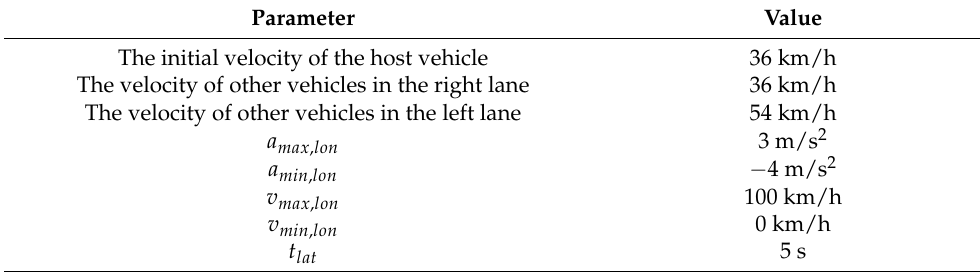
Figure 14. The traffic scenario during the lane-change process. Table 3. The simulation